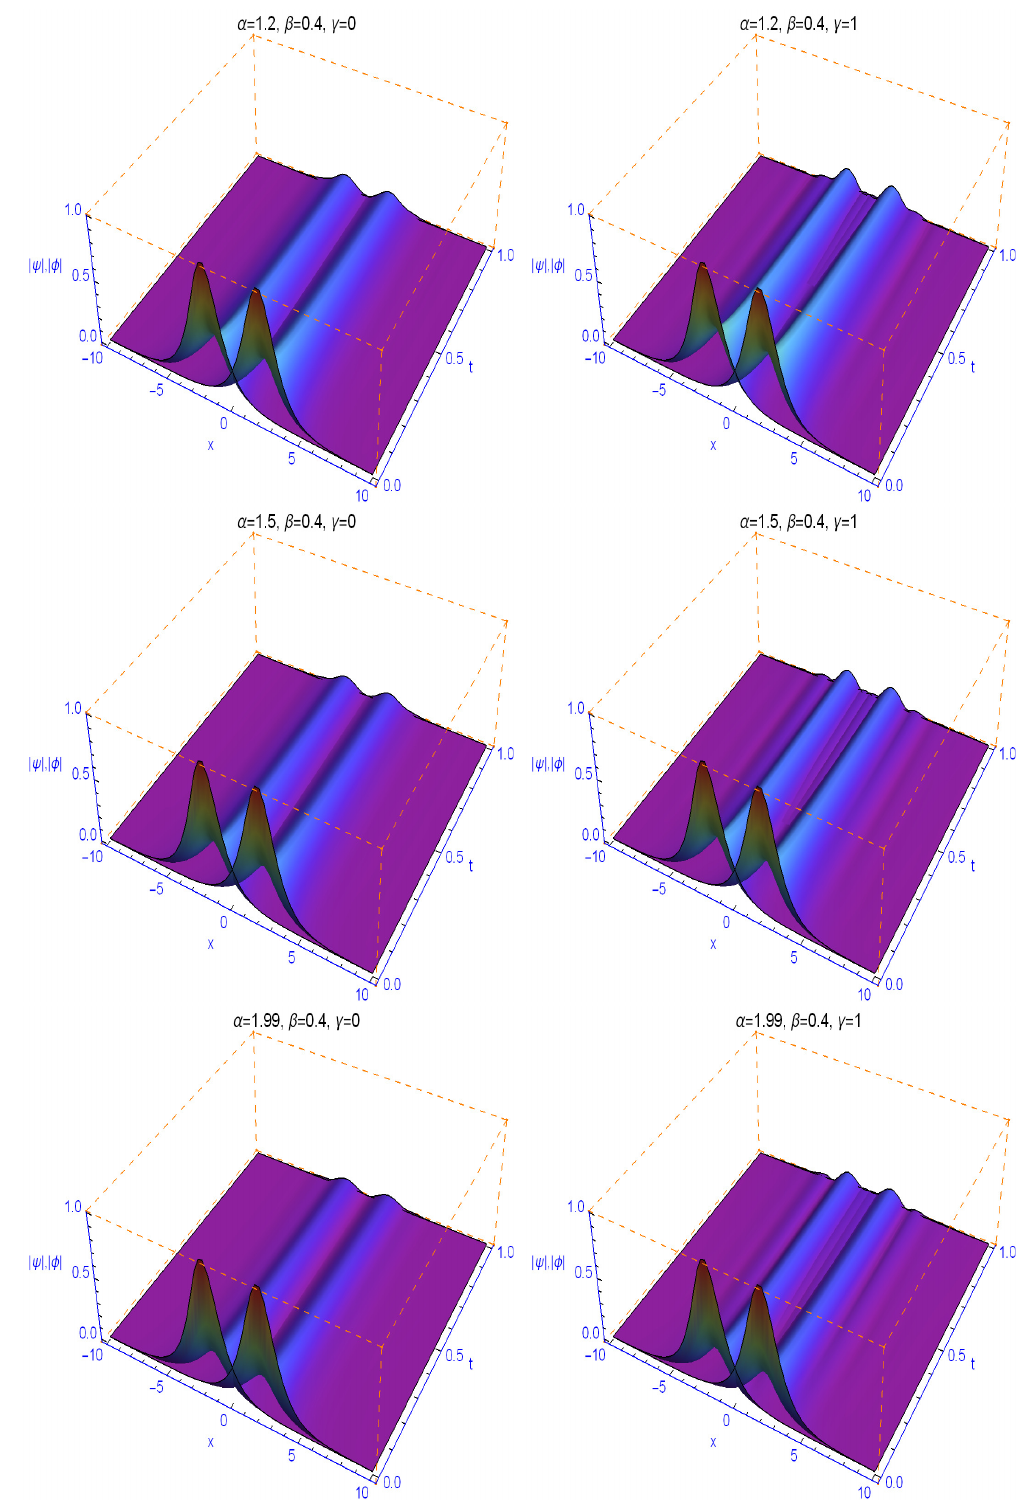
Figure 4. The evolution of | ψ N | and | φ N | for different values of γ 1 = γ 2 = γ = 0,1. The first row is presented at α = 1.2 and β = 0.4. The second row is presented at α = 1.5 and β = 0.4. The third row is done at α = 1.99 and β =